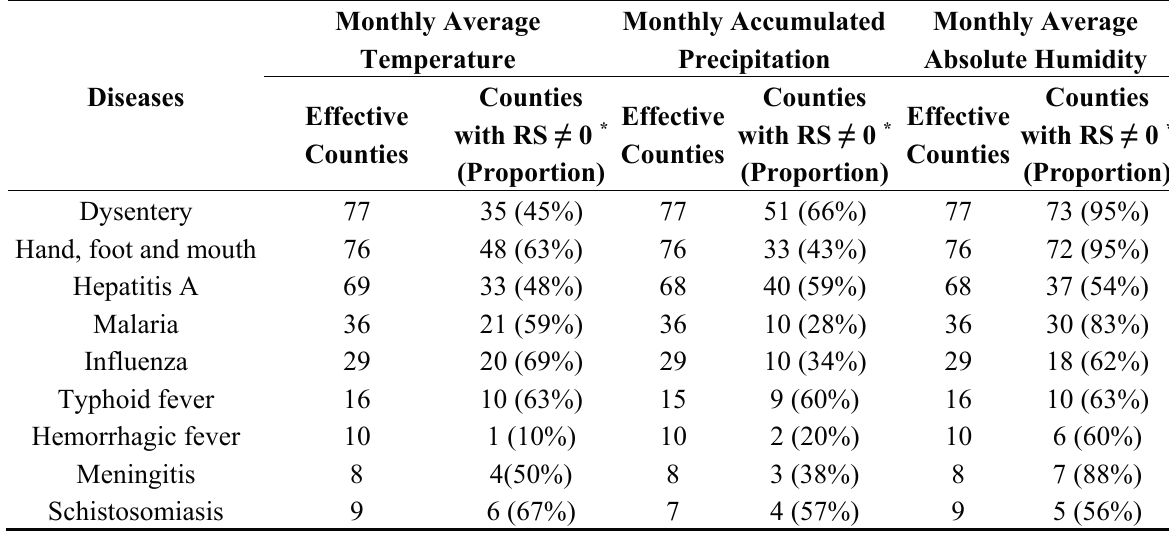
Table 3. The screening results for climate change-sensitive disease using RS indicator in Anhui